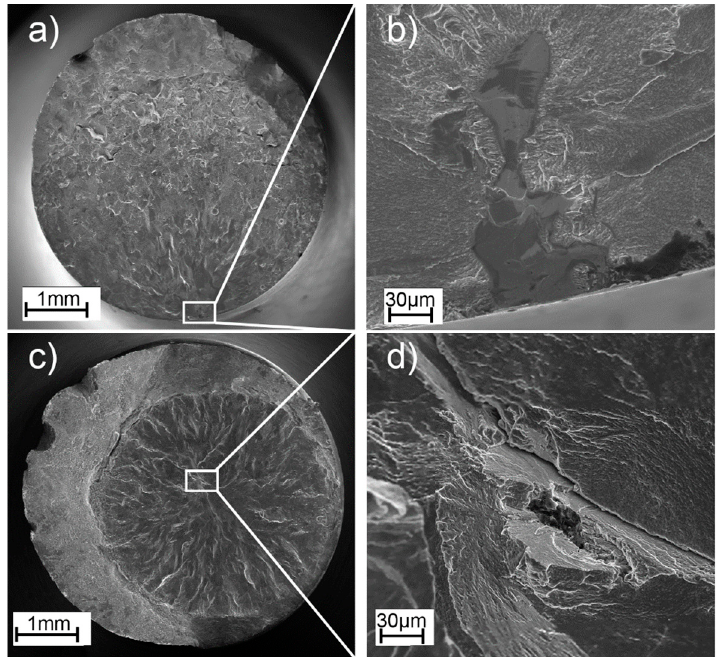
Figure 15. Representative SEM images of the fracture surfaces of components subjected to cyclic loading with the marked fracture initiation site: ( a , b ) as-built, applied stress of 500 MPa/819892 cycles; ( c , d ) HIP, applied stress of 650 MPa/2985343 cycles.